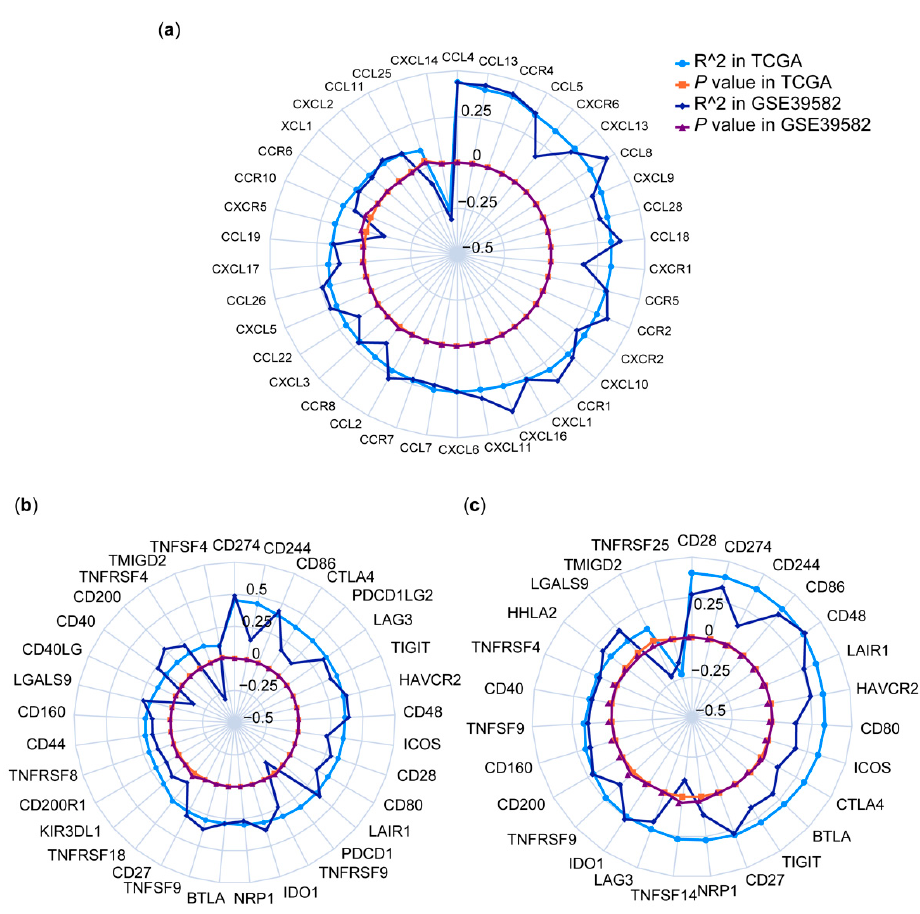
Figure 6. Correlation analyses of HPSE and immune genes expression in CRC. ( a ). Correlation between expression of HPSE and chemokine family. ( b ) Correlation between expression of HPSE and immune checkpoint genes. ( c ) Correlation between expression of HPSE and immune checkpoint genes in the pMMR subgroup. Genes with p < 0.05 were shown in the radars.